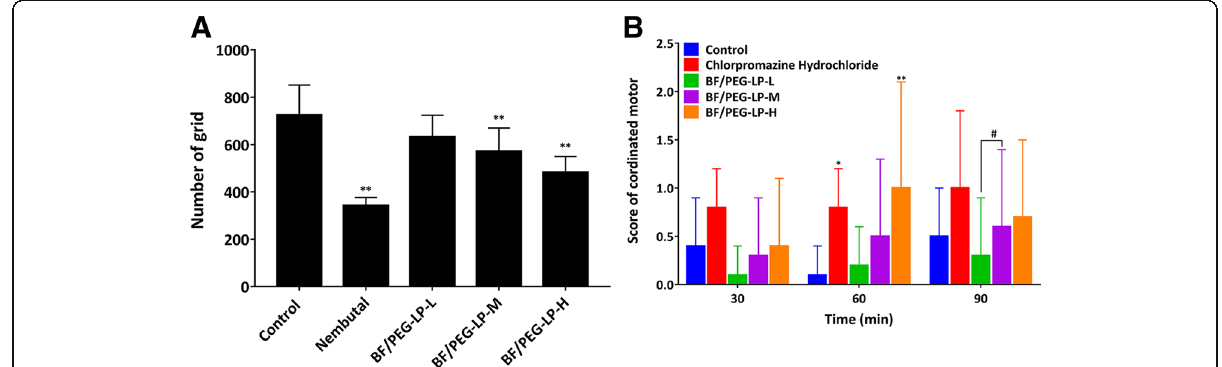
Fig. 3 Pharmacological effect of BF/PEG-LP on locomotor activity ( a ) and coordinated exercise ( b ) in mice. Data are presented as (cid:2) x ± s ( n = 10). *P < 0.05, * * P < 0.01 vs . control group at each time point; # P < 0.05 vs. low-dose BF/PEG-LP group. Abbreviations: BF/PEG-LP, bufalin-loaded PEGylated